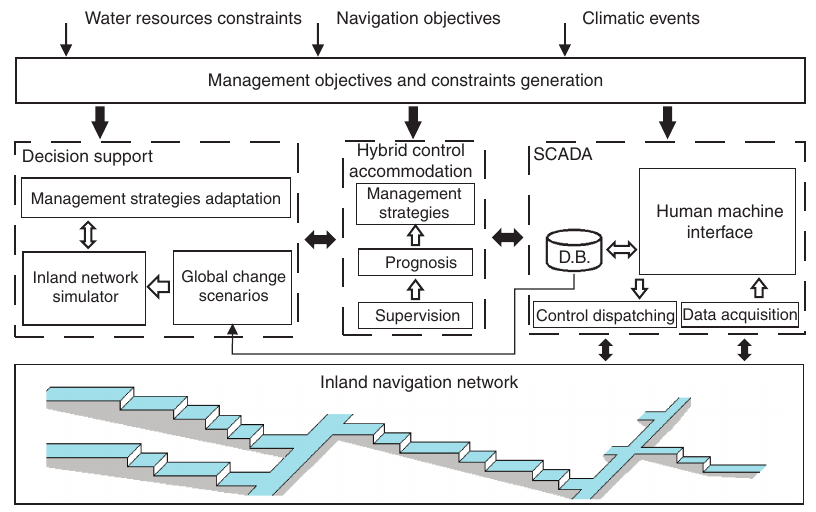
Figure 2. Adaptive and Predictive Control Architecture.